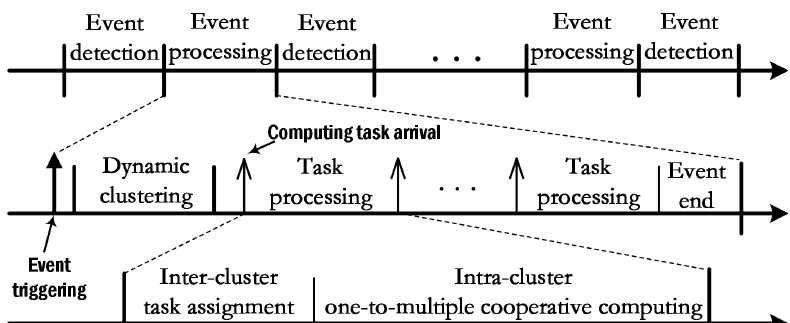
Figure 2. The workflow of event-driven